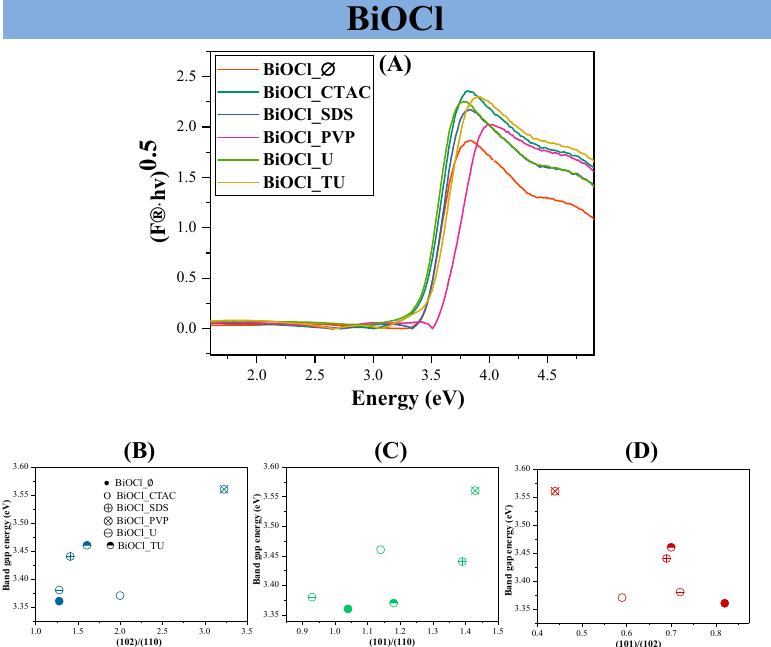
Figure 3. The diffuse reflectance spectra of the obtained BiOCl semiconductors ( A ); the correlation between the band gap values and (102)/(110) ( B ), (101)/(110) ( C ) and (101)/(102) ( D ) crystallographic plane ratios .